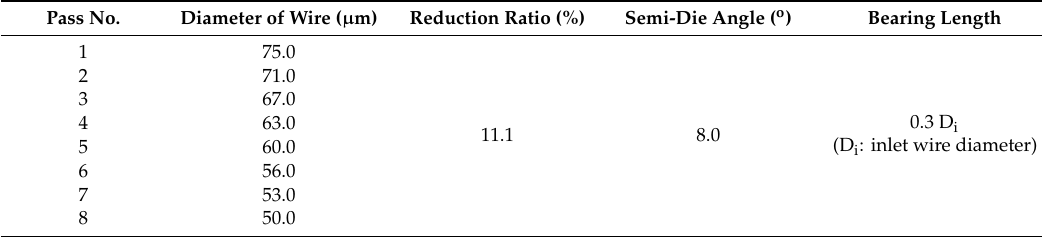
Table 3. The designed pass schedule.